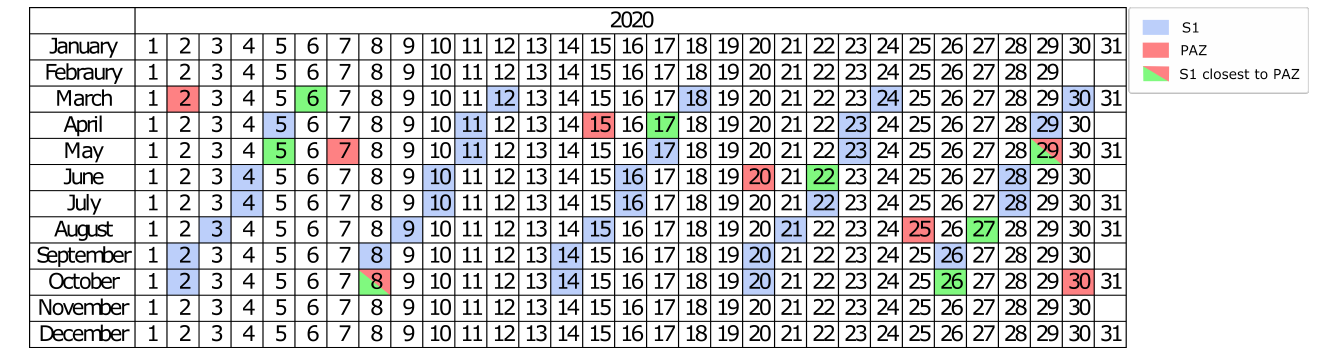
Figure 2. Acquisition dates of the PAZ and Sentinel-1